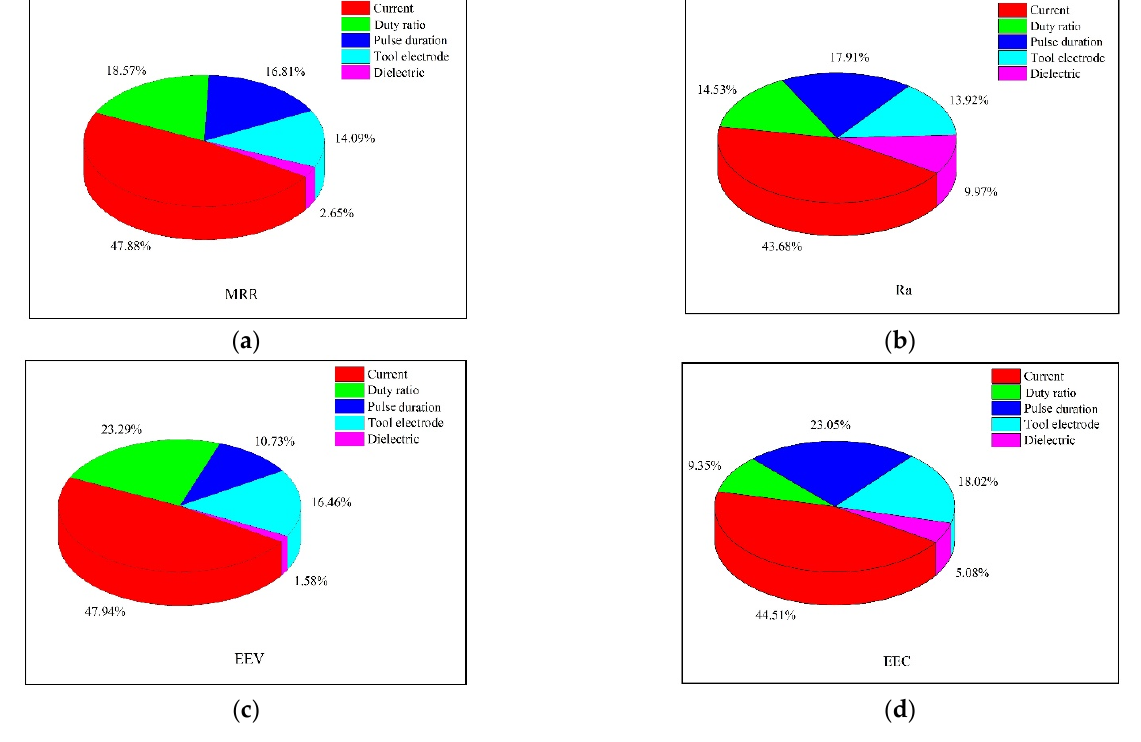
Figure 13. Comparison of the influence of parameters on processing performance; ( a ) influence of process parameters on MRR; ( b ) influence of process parameters on Ra; ( c ) influence of process parameters on EEV; ( d ) influence of process parameters on EEC.